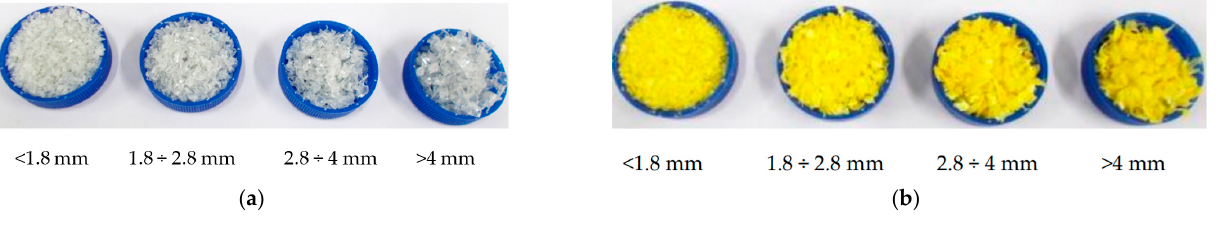
Figure 5. The sieved polymer fractions for electrification process: ( a ) PET, ( b ) PE-HD.